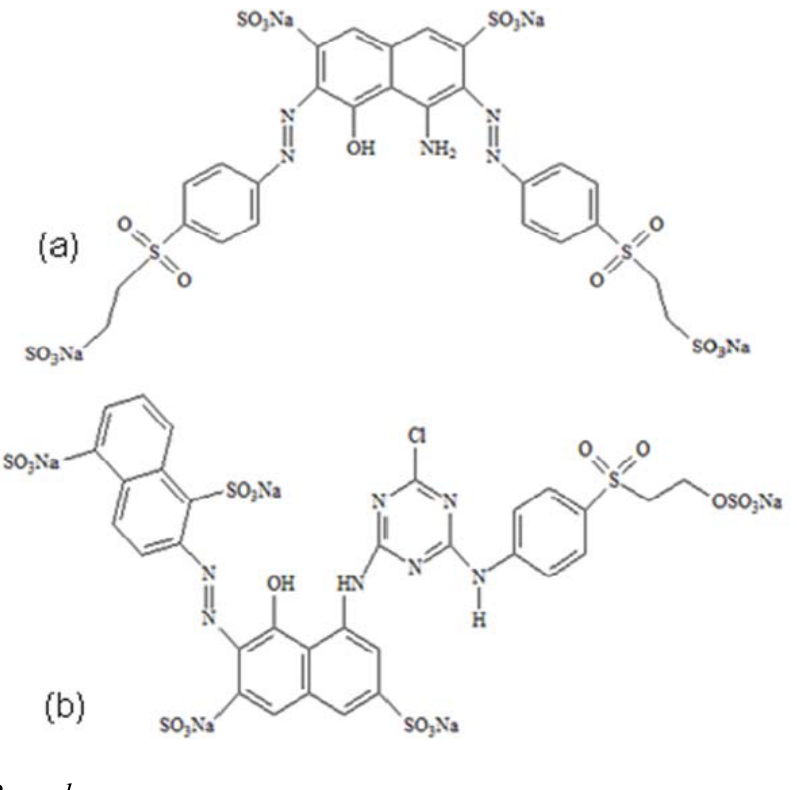
Figure 12. Chemical structure of commercial azo dyes: (a) Marine Remazol RGB 150% gran (C.I Reactive Black 5). (b) Ultra Red Remazol gran (C.I. Reactive Red